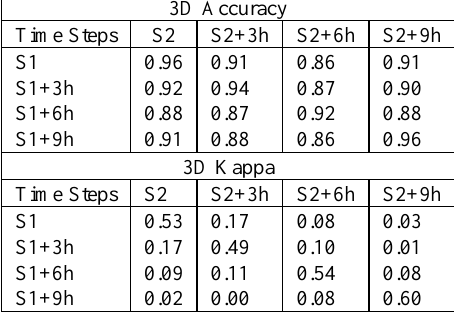
Table 2 . Values obtained for 3D Accuracy and 3D Kappa for